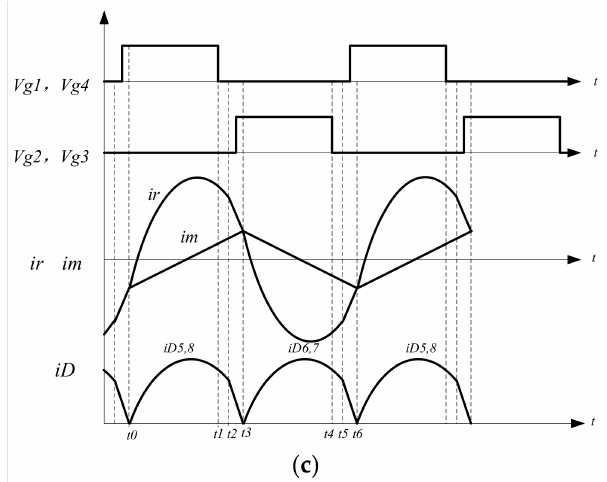
Figure 2. The working waveform of the full-bridge LLC resonant converter. ( a ) f m < f s < f r ( b ) f s = f r ( c ) f s > f r